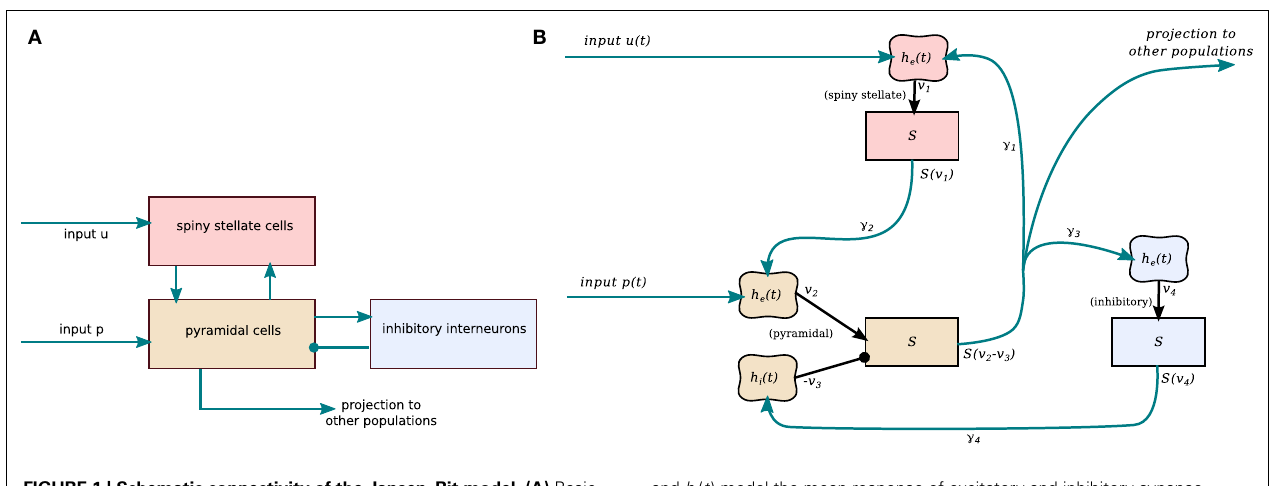
FIGURE 1 | Schematic connectivity of the Jansen–Rit model. (A) Basic connectivity diagram showing the three neuronal populations, their excitatory (arrows) and inhibitory (circle) connections, and inputs from outside the local cortical region ( u and p ). (B) A block diagram then summarizes how this translates directly to a mathematical model: linear filter boxes labeled h e ( t )